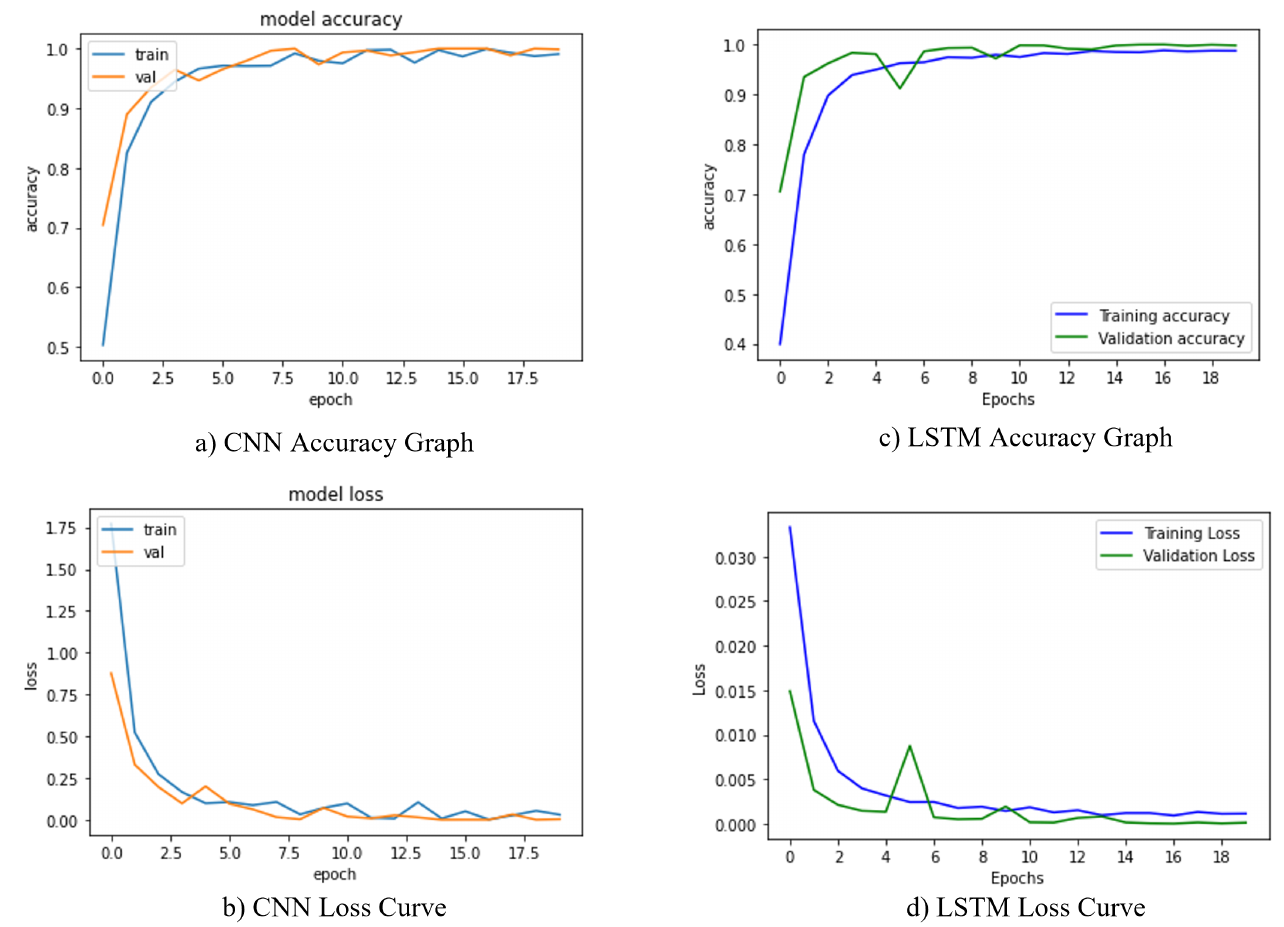
Figure 8. Training and validation loss curves of the proposed model. ( a , b ) shows the accuracy and loss curves for CNN model. ( c , d ) represents the accuracy and loss curves for the LSTM model. Evaluation